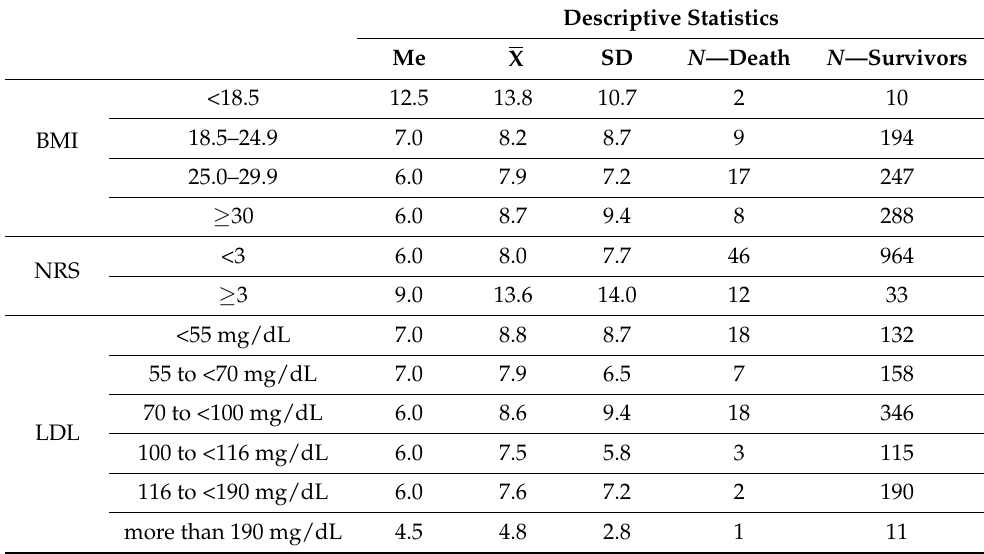
Table 7. Descriptive statistics for survival time, number of deaths, and survival rate according to BMI results, NRS scores, and LDL scores.